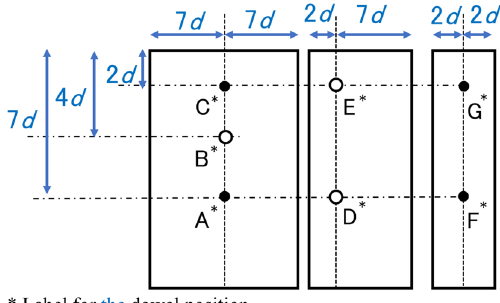
Fig. 1 Combination of the dowel position and ph. * Label for the dowel position. Four tests of ph (i.e., 0, 1/3, 2/3, and 1) were conducted at the dowel positions indicated by black circles. Two tests of ph (0, 1) were conducted at the white circled dowel positions. d and ph mean the dowel diameter and the pilot hole size, respectively